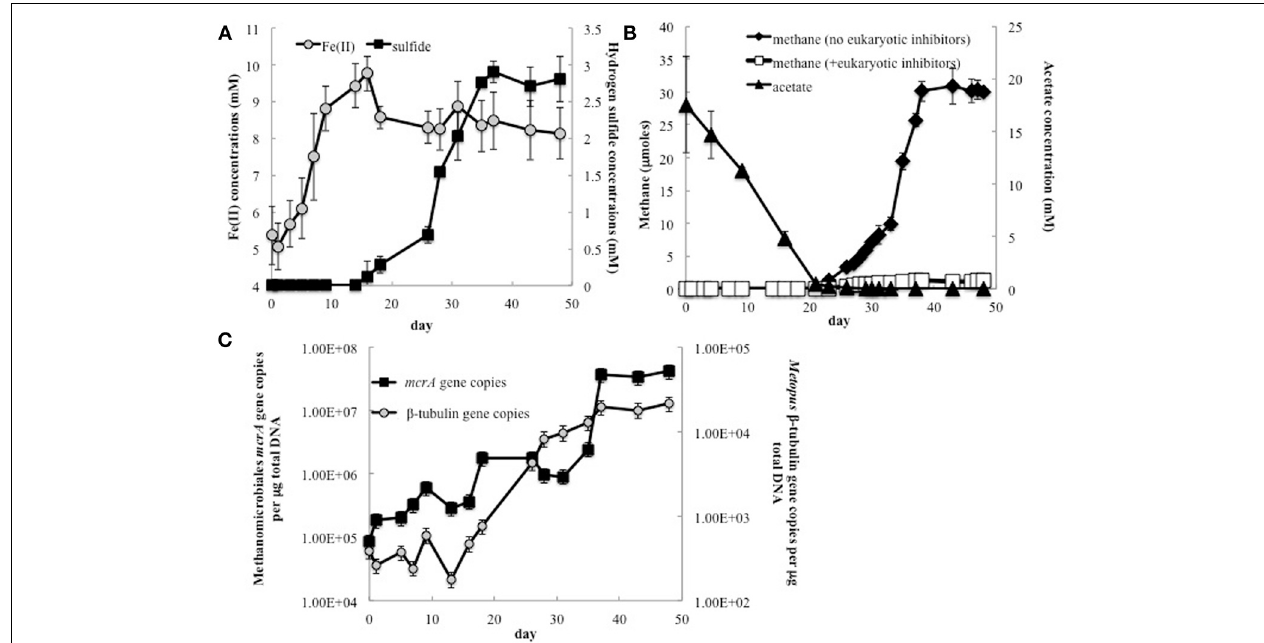
FIGURE 5 | (A) Fe(II) and H 2 S concentrations in groundwater collected from Rifle sediment microcosms; (B) Methane and acetate concentrations in sediment incubations with and without addition of the eukaryotic inhibitors